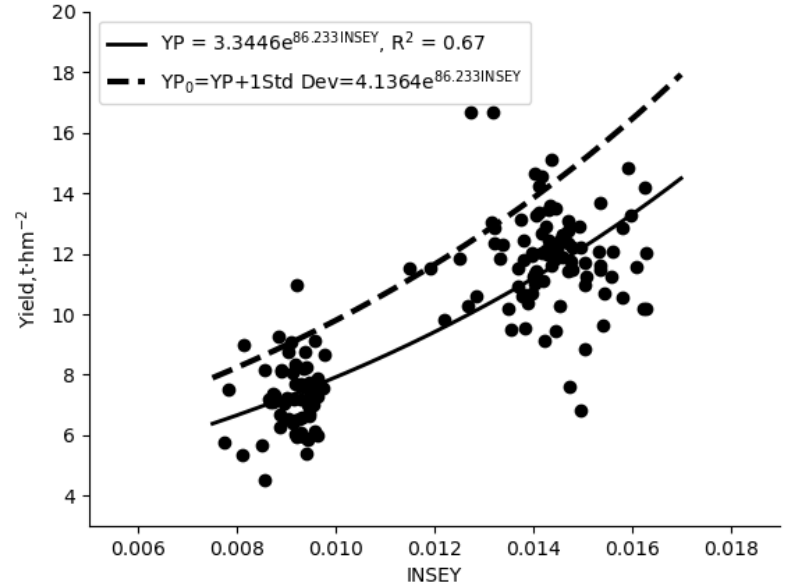
Figure 4. Model of predicting potential. YP (solid line): original forecast potential production; YP 0 (dotted line): adjusted forecast potential production.